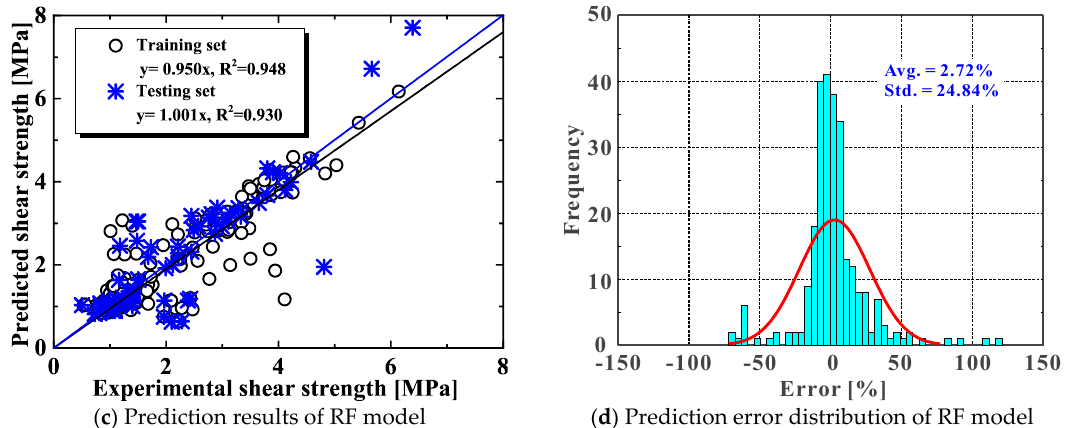
Figure 5. Prediction results and error distributions of the two machine learning (ML) models.